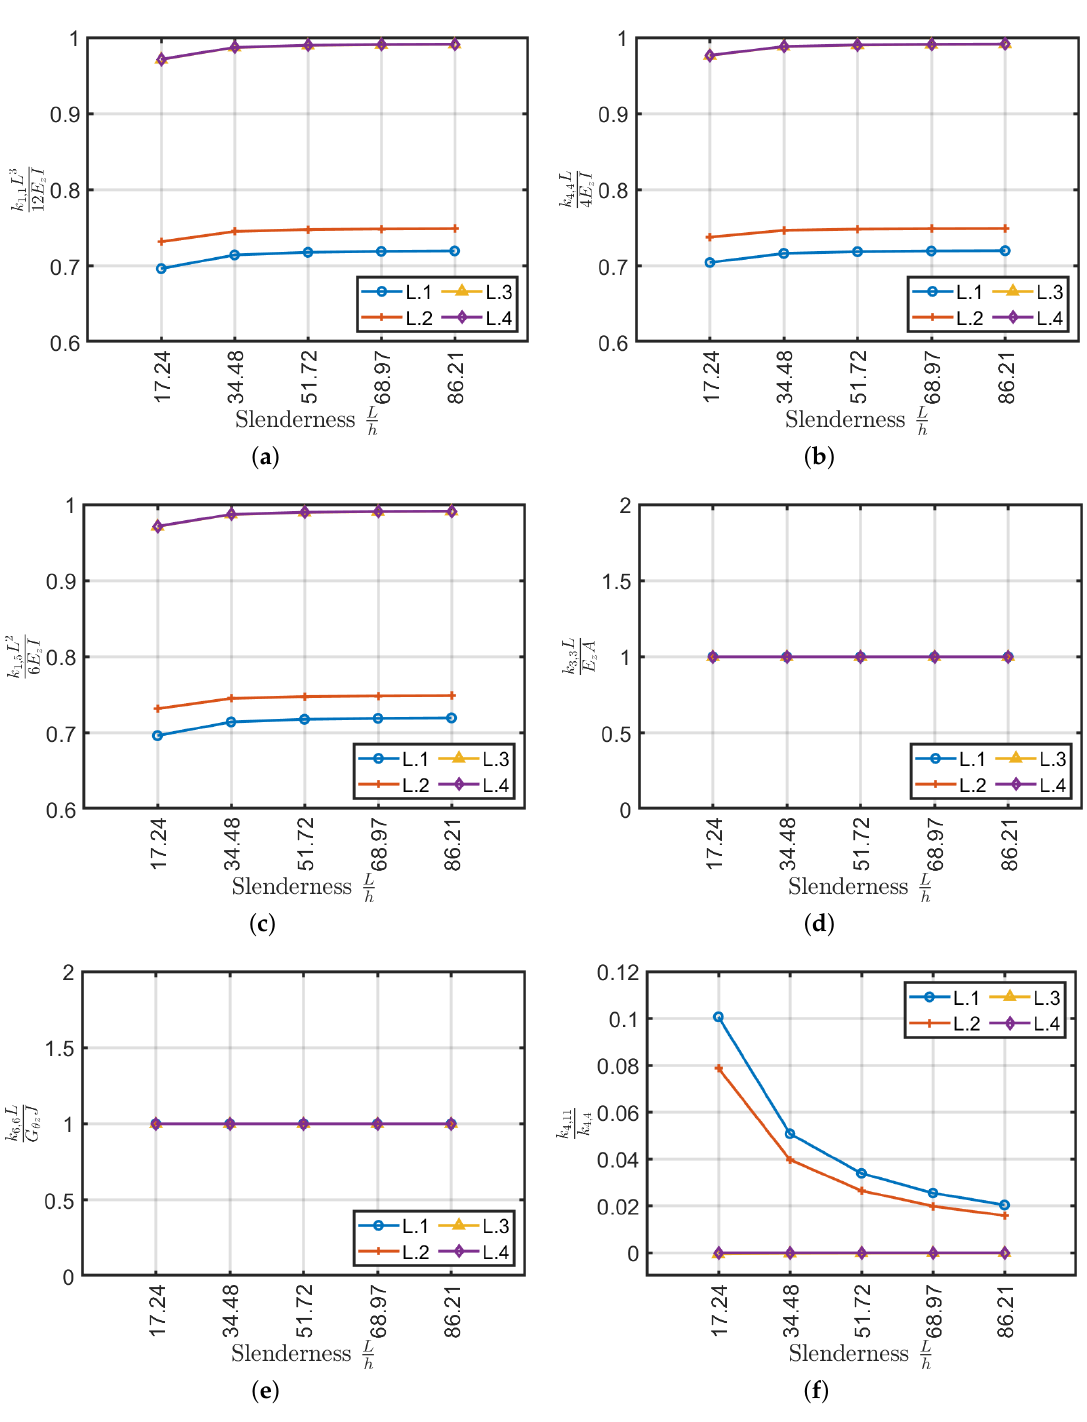
3 , ( b ) k 4,4 L 12 E z I 4 E z I